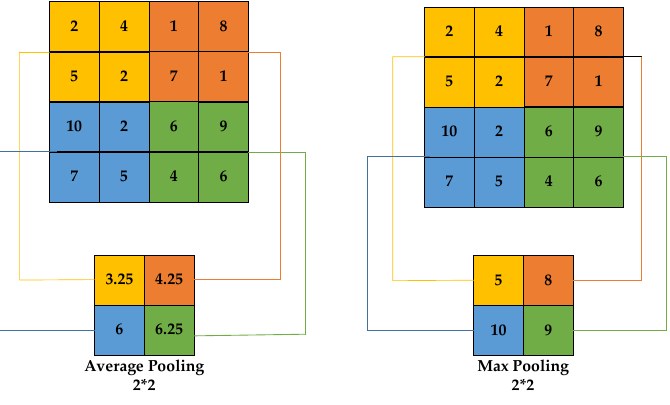
Figure 8. Pooling operation